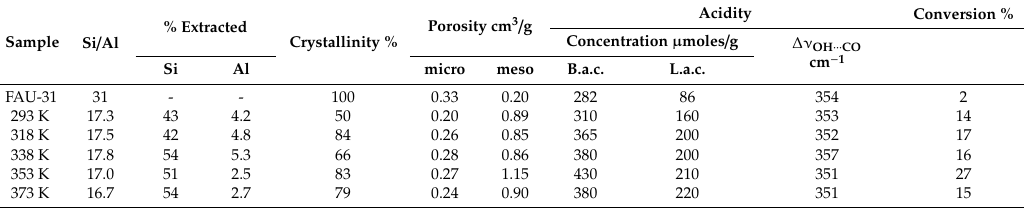
Table 3. The Si / Al values, the amounts of Si and Al extracted, crystallinity, N 2 porosity, concentration of Brønsted and Lewis acid sites, the acid strength of Si-OH-Al groups ( ∆ ν OH ··· CO ). Conversion in α -pinene isomerization after 5 min of reaction at 363 K. The data concerning parent zeolite Y (FAU-31) and zeolites desilicated with NaOH / TBAOH mixture at various temperatures (293, 318, 338, 353 and 373 K). The data were adapted (with the permission) from [53].